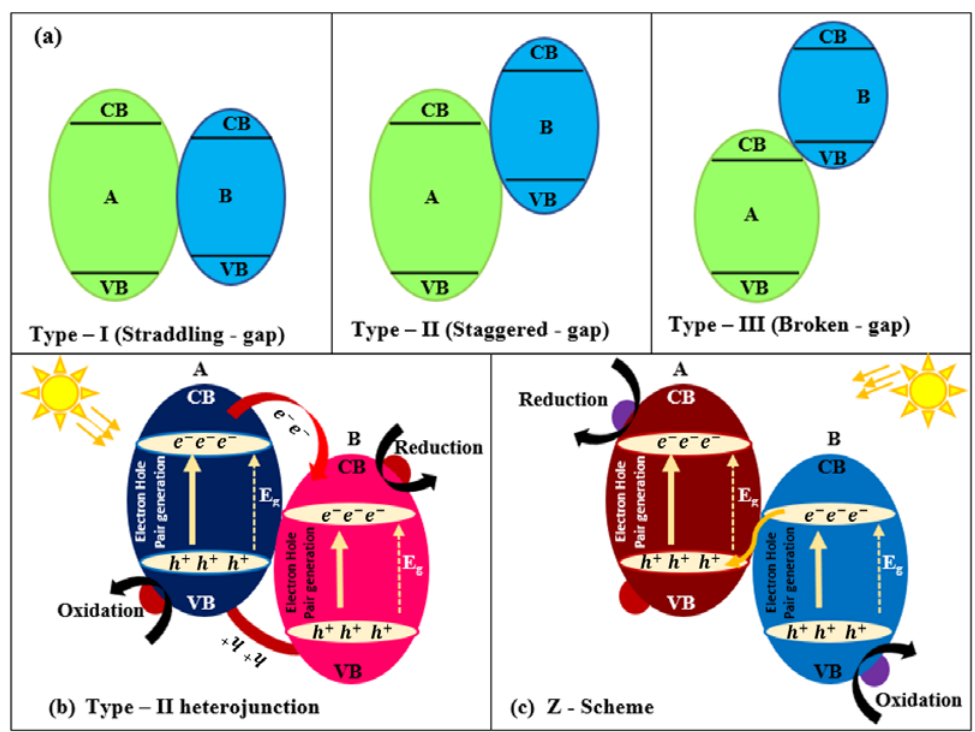
Figure 21. ( a ) Schematic illustration of three types of heterojunction. Charge generation and move- ment in ( b ) Type II heterojunction and ( c ) Z-scheme heterojunction.